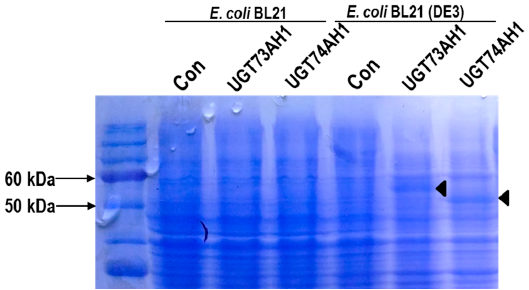
Figure 4. SDS-PAGE analysis of UGT73AH1 and UGT74AH1 heterologously expressed in Escherichia